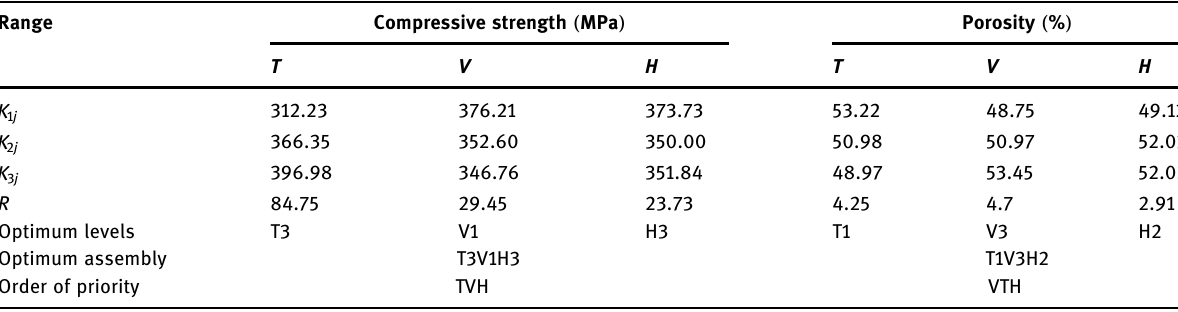
Table 4: The range analysis of the compressive strength and